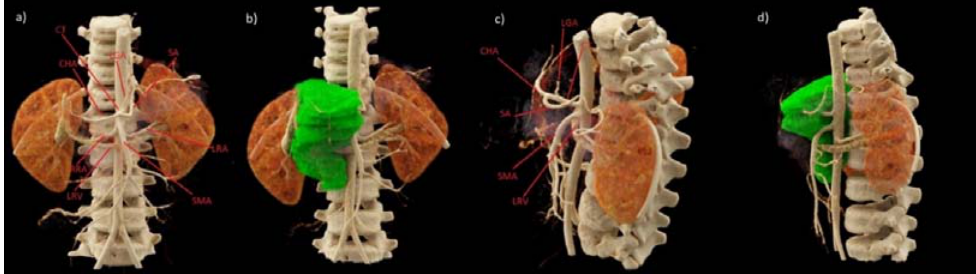
Figure 2. Preoperative abdominal computed tomography (CT) scan in the arterial phase with 3D VRT reconstructions ( a – d ), additionally visualizing the mass of the tumor ( b , d ). CT—coeliac trunk, SA—splenic artery, CHA—common hepatic artery, LGA—left gastric artery, SMA—superior mesenteric artery, RRA—right renal artery, LRA—left renal artery, LRV—left renal